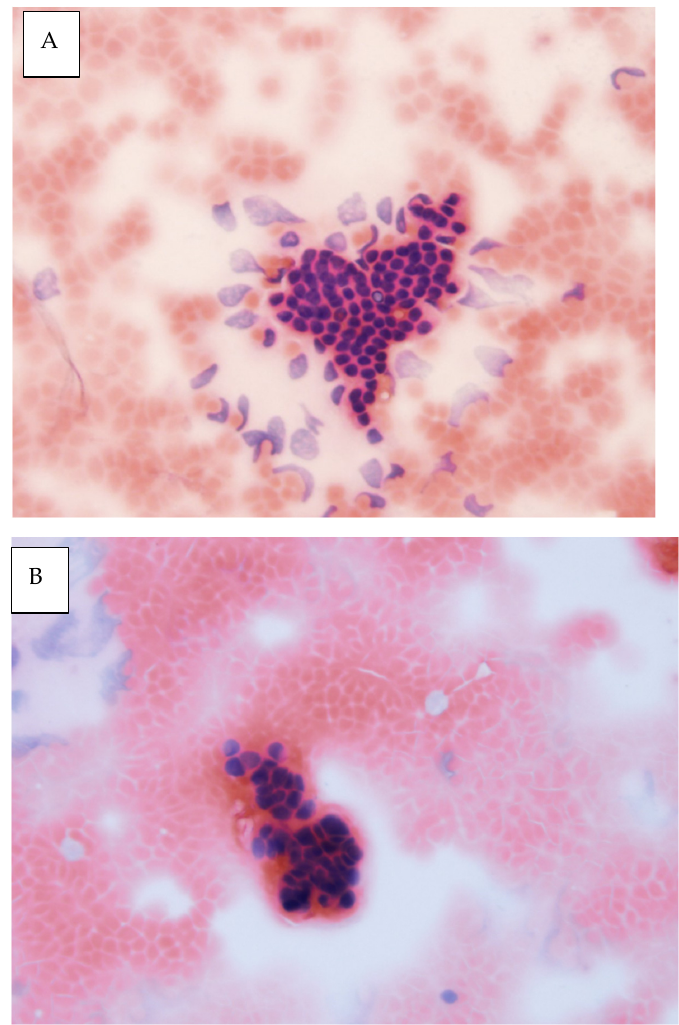
Figure 1. ( A ): A tuft of benign ductal epithelial cells with a regular arrangement of polarized uniform nuclei. Hematoxylin–eosin staining (100×). PAP II; ( B ): A cluster of malignant cells with irregular hyperchromic congested, often angular nuclei with irregular karyomembrane. Hematoxylin–eosin staining (100×). PAP VI.